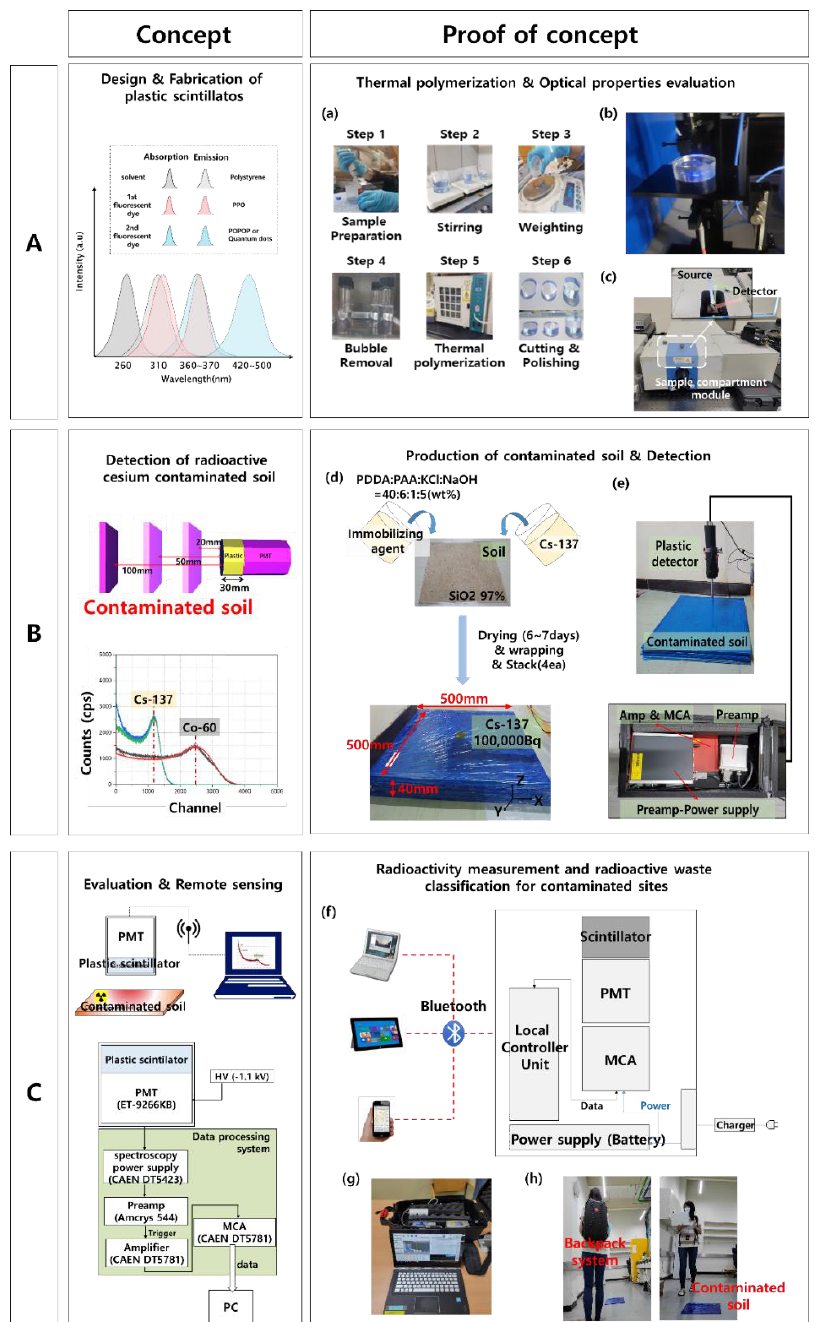
Figure 1. The overall schematic illustrations of a wireless mobile system for the detection of radio- active cesium on contaminated soil. ( A ) Manufacturing of plastic scintillator and optical properties. ( B ) Radiological measurement using a contaminated soil plate and performance evaluation of QD- based plastic scintillator. ( C ) Manufacturing and application of mobile and wireless communication systems.